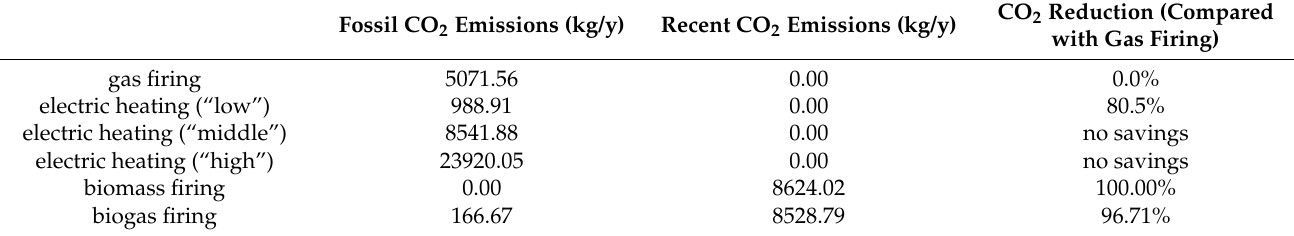
Table 3. CO 2 emissions of the studied heat pump systems in kg/y in the case of a theoretical house with a heat demand of 90.00 GJ/y.